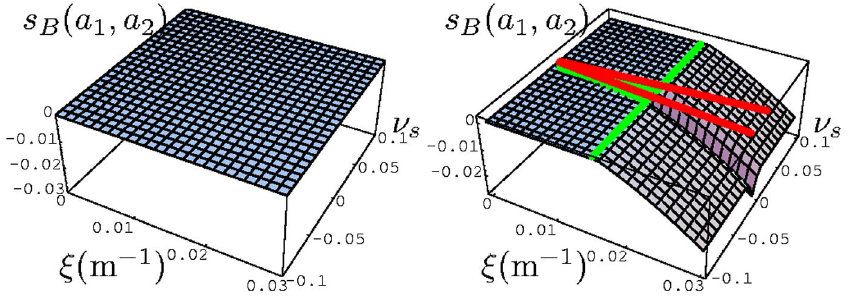
5. (Color) Unstable region caused by a crab cavity for (cid:28) close to a half integer with cot (cid:25) Light green: border of stability; dark red: border of stability from the approximate Eq. (32).